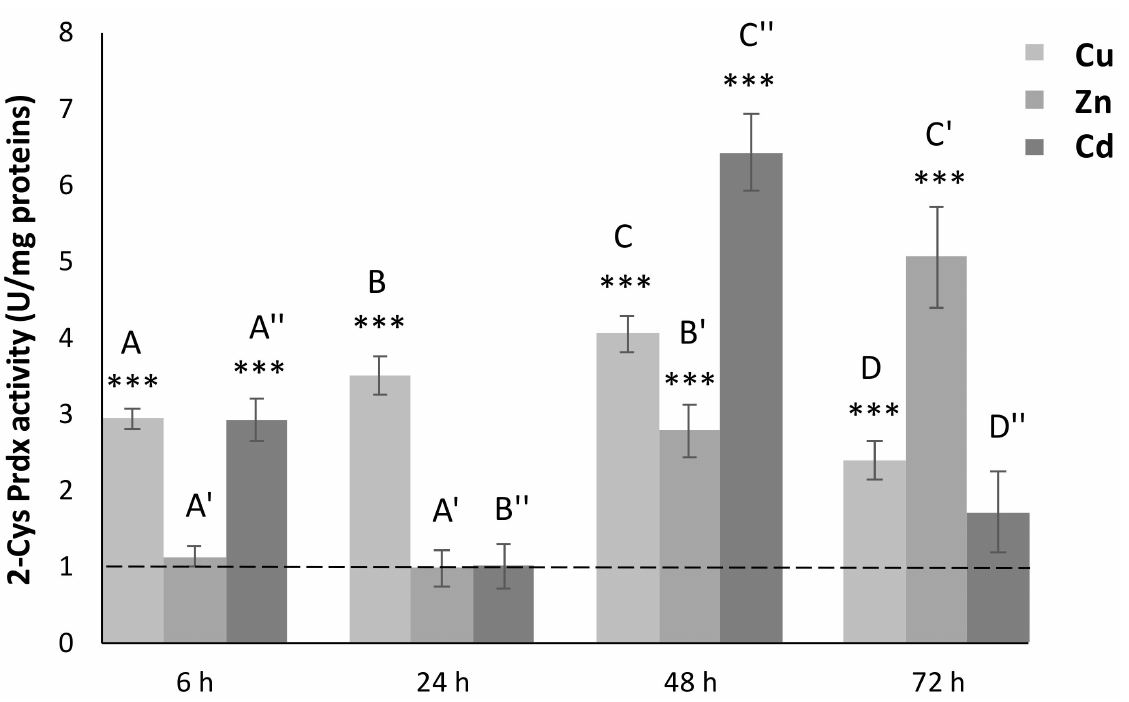
Figure 3. 2-Cys Prdx activity levels in the intestine of C. robusta during metal exposure (Cu, Zn and Cd). Values are indicated as mean ± SD. Protein levels were normalized with respect to controls (dashed line). Asterisks: significant differences with respect to controls (*** p < 0.001). Different letters with the same index correspond to significant statistical differences ( p < 0.05) among different treatment times (Duncan’s